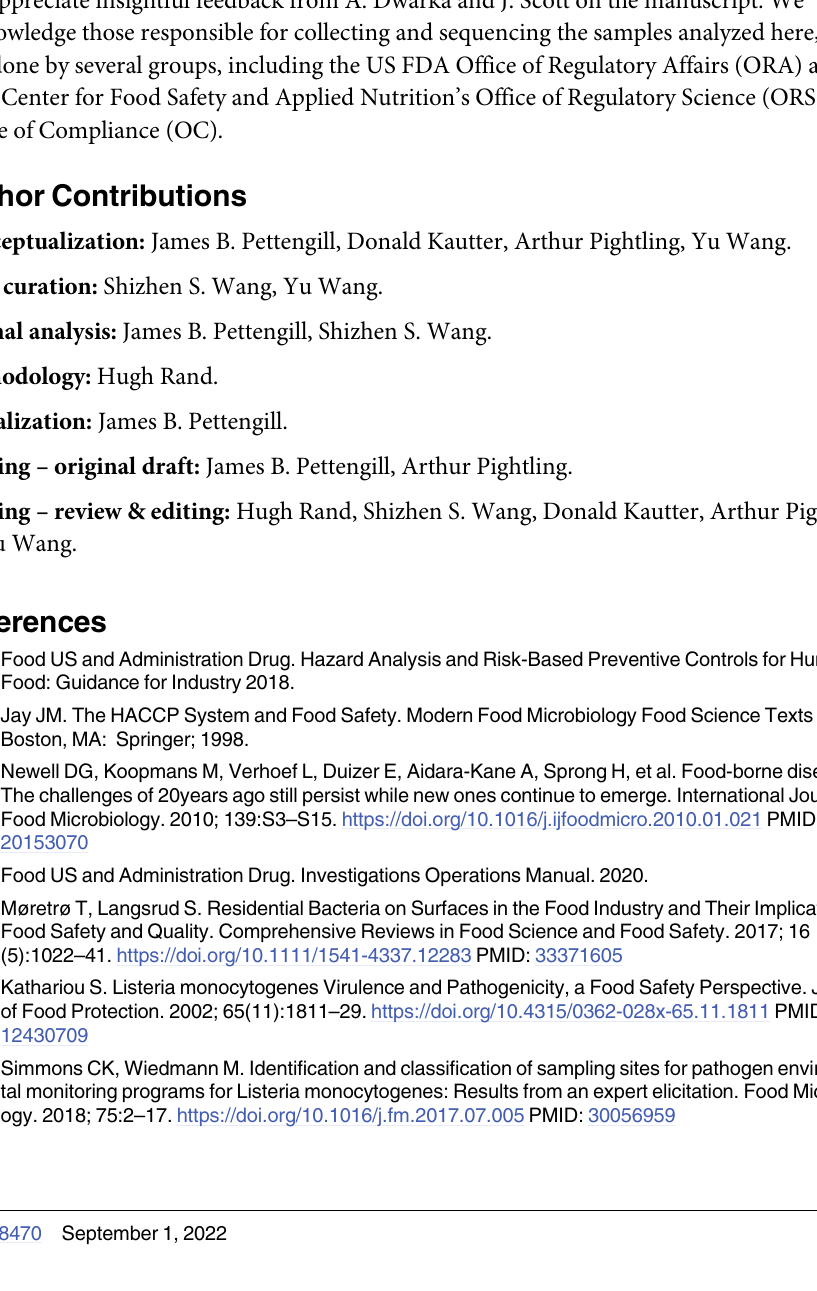
S1 Table. NCBI (National Center for Biotechnology Information) SRA (sequence read archive) and BioSample accessions for sequence data analyzed. S2 Table. Lineages and sequence types of L . monocytogenes as predicted with the program mlst (25) that uses the PubMLST (26)